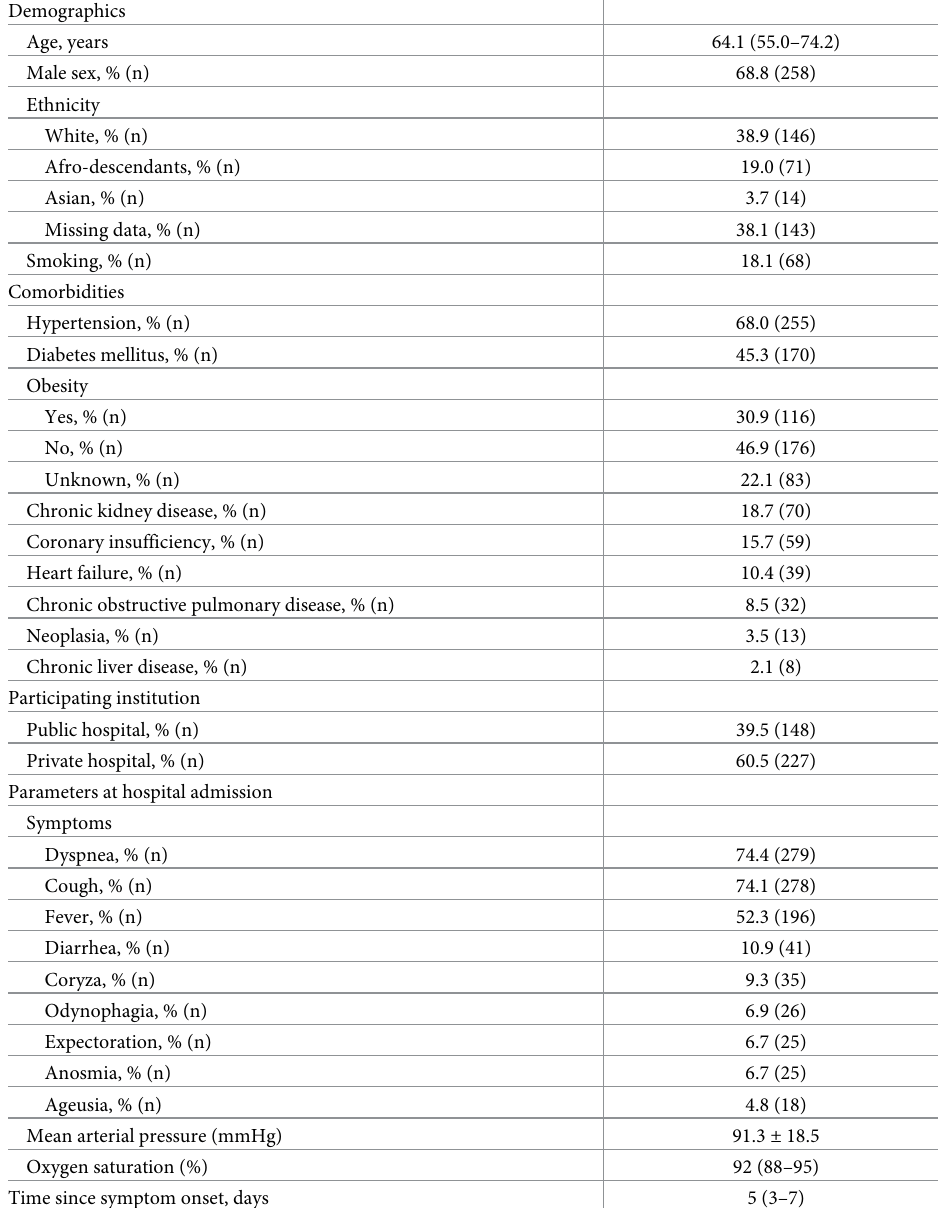
Table 1. General characteristics of the study population (N =